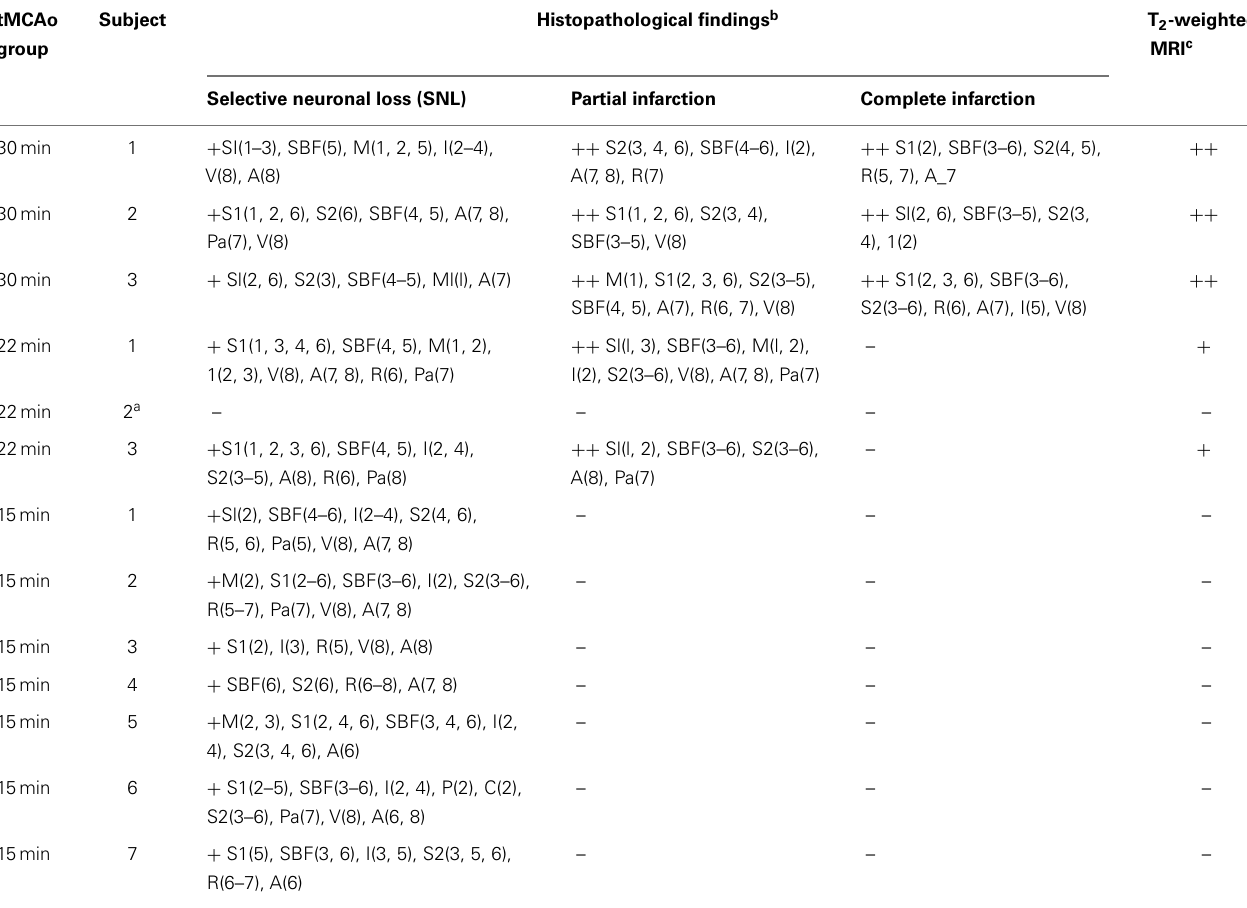
Table 1 | Summary of the histopathological andT 2 -weighted MR findings obtained in each rat 28days after 15min temporary MCA occlusion